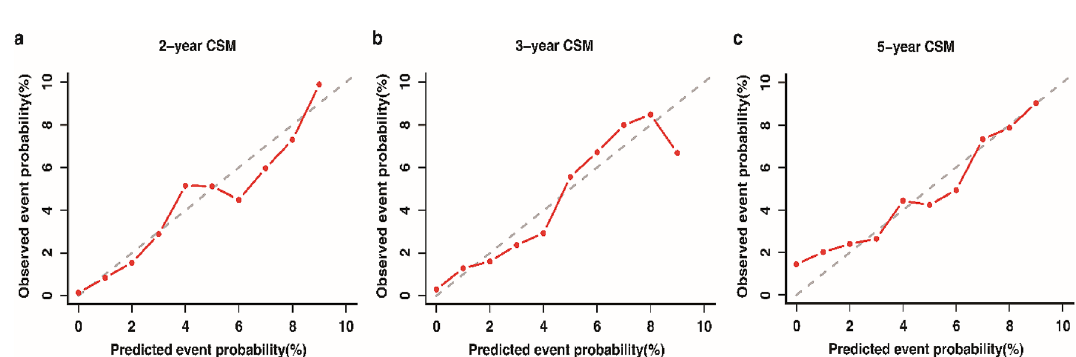
Figure 5. Competing risk nomogram predicting 2-, 3- and 5-year probabilities of CSM. CSM cancer-specific mortality. The figure was performed using R software (version 4.0.3, R Core Team 2020, https:// www.r- proje ct. org/).